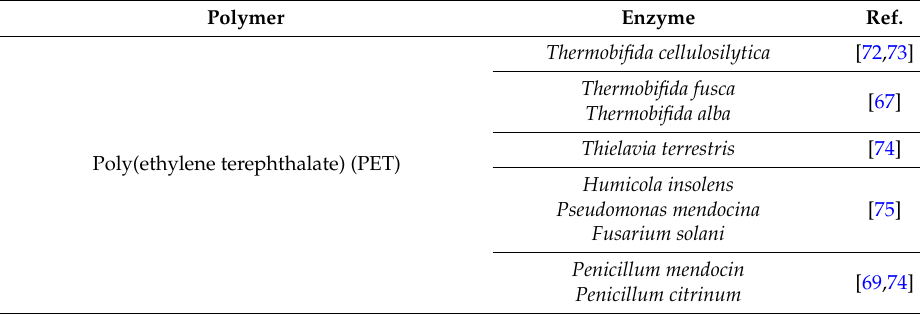
Table 2. Polyesters and polyamides that were hydrolyzed via cutinase-catalyzed